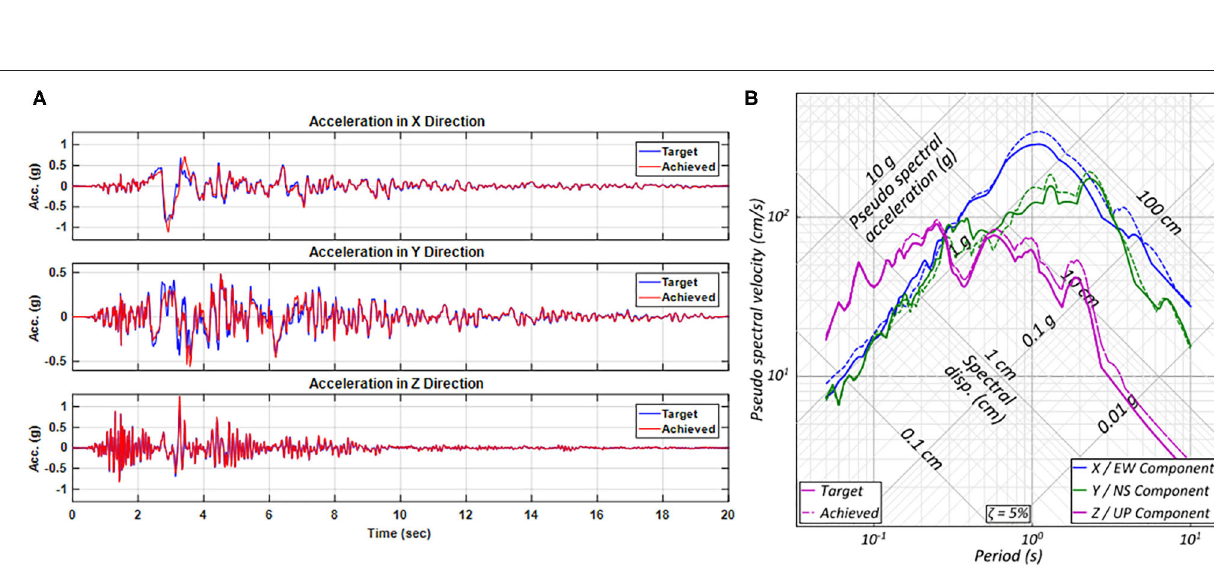
Frontiers in Built Environment |